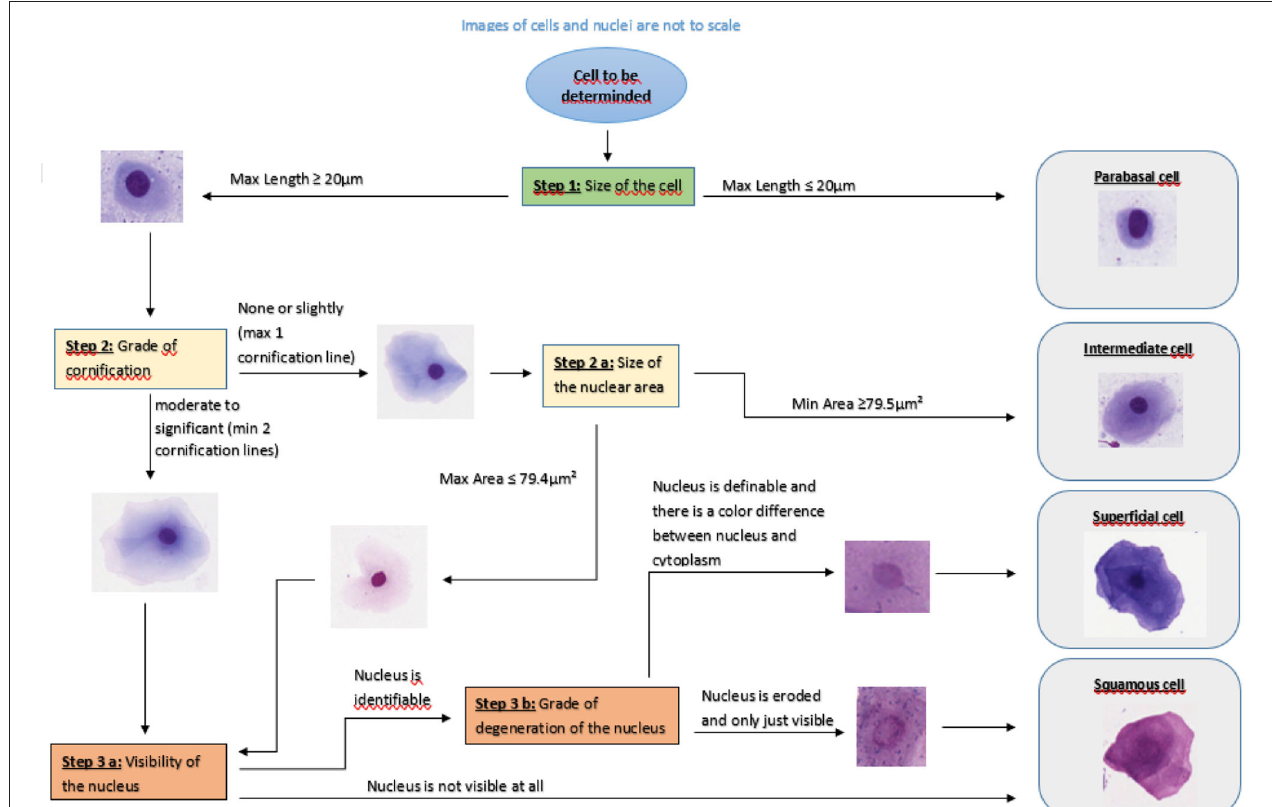
FIGURE 1 | Flowchart for the determination of the cell type of exfoliated canine vaginal cells.